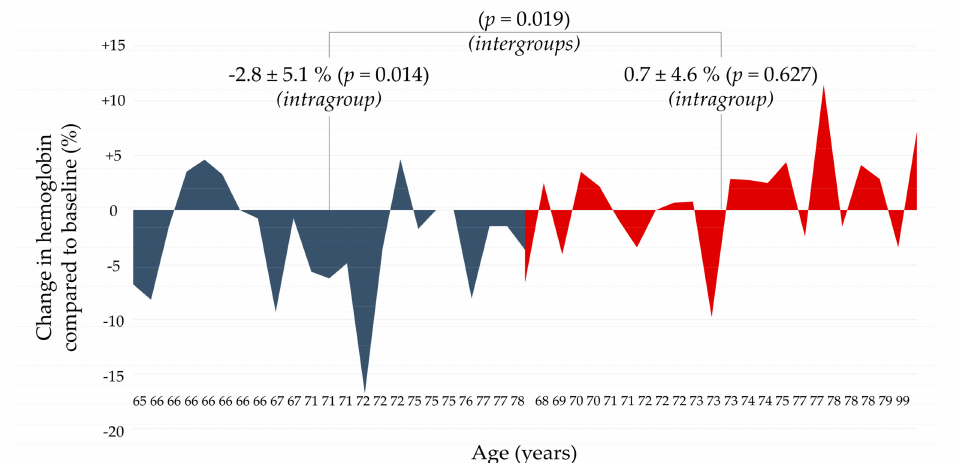
Figure 1. Area charts of hemoglobin changes, expressed as a percentage from baseline, in the subgroup of older adults within 30 days prior to hip or knee surgery. Control group: blue. Intervention group: red. The treatment consisted of daily supplementation of 30 mg of sucrosomial ferric pyrophosphate and 70 mg of L-ascorbic acid. In the y -axis is the percentage change in hemoglobin (%), whereas in the x -axis is the age of subjects. The oldest subjects in the control group appear to lose more hemoglobin than their youngest counterparts, but the oldest are also those that respond the more to treatment in the red group. In the control group, the cumulative absolute decrease in hemoglobin from baseline was − 11.7 g / dL and in the intervention group was − 4.6 g /